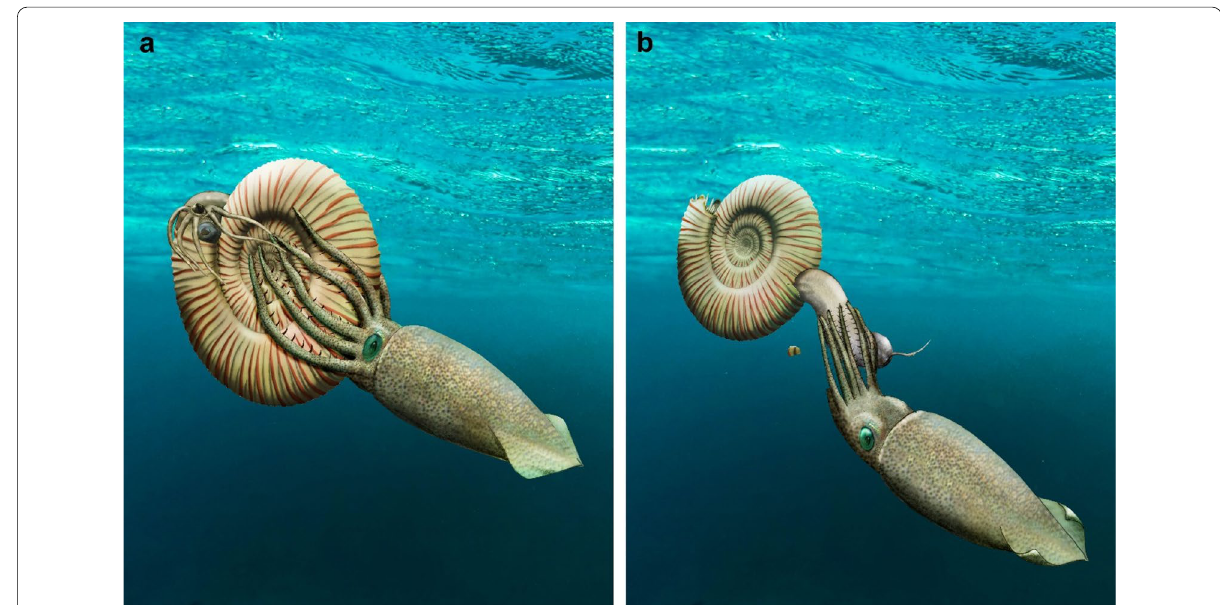
Fig. 7 Reconstruction of a possible sequence of events that led to the separation of the soft parts from the conch of Subplanites. a Acanthoteuthis attacks the ammonite and breaks the conch in the posterior half of the body chamber. b Acanthoteuthis withdraws the soft parts. Possibly, the arm crown remained attached to the aperture or was eaten away